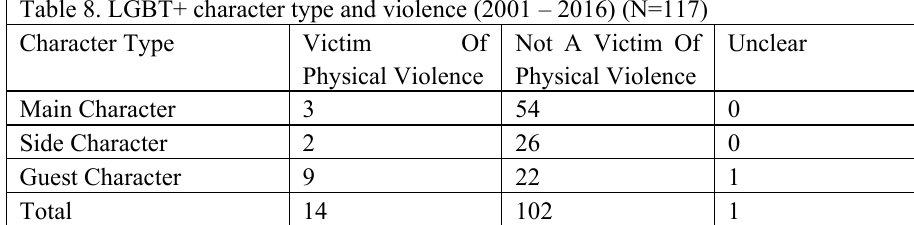
Table 8. LGBT+ character type and violence (2001 – 2016) (N=117) Character Type